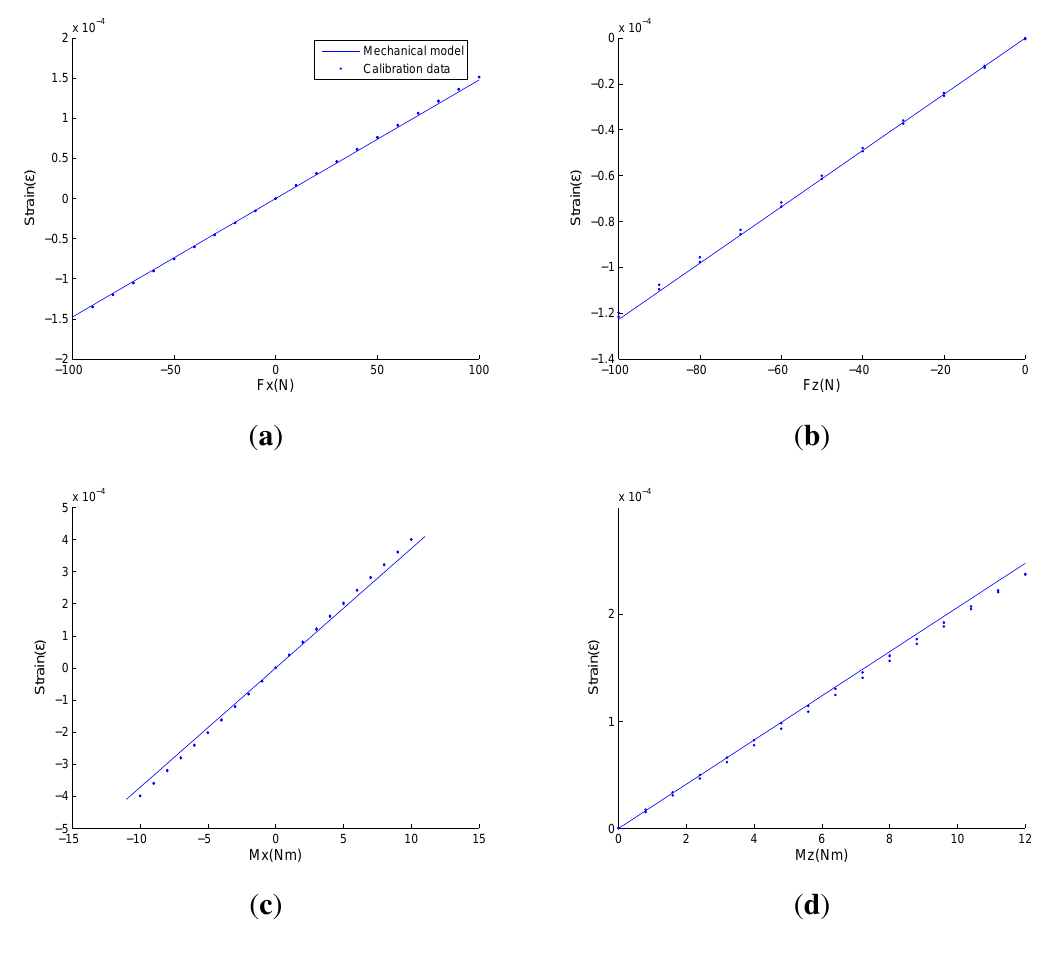
; ( c ) Strains on strain-gauge-locations under M z . z